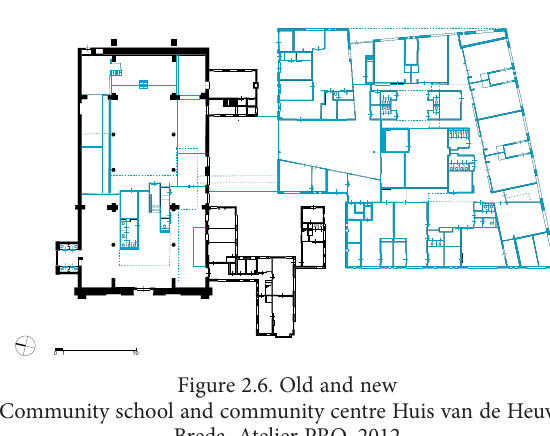
Figure 2.6. Old and new Community school and community centre Huis van de Heuvel, Breda, Atelier PRO, 2012 Black: original building, coloured: added parts Figure 2. To be